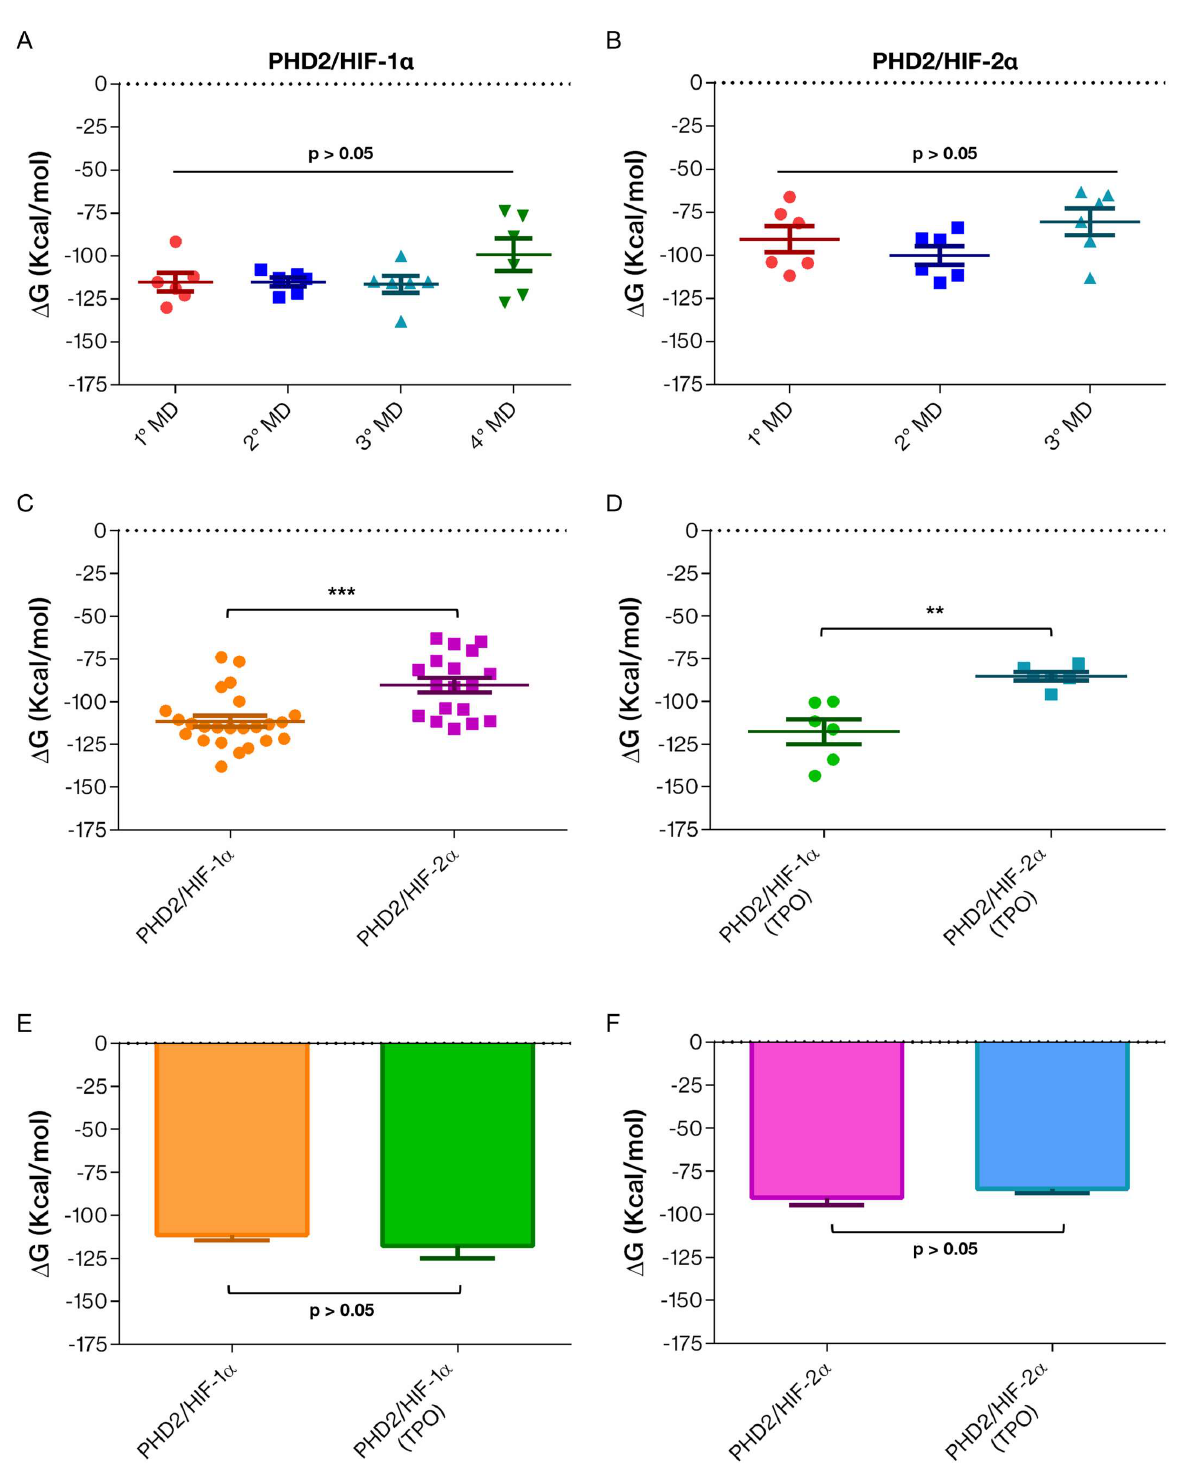
Figure 8. Scatter dot plots and bar plots (mean with SEM) representing the difference in the mean value of the binding free energy (ΔG) among all the complexes. ( A ) A scatter dot plot for ΔG value among the four replicas of the PHD2/HIF-1α complex, N = 24; 1st MD (−115.1 ± 5.356); 2nd MD (−115.1 ± 2.603); 3rd MD (−116.5 ± 4.979); and 4th MD (−99.15 ± 9.370). ( B ) Scatter dot plot for ΔG